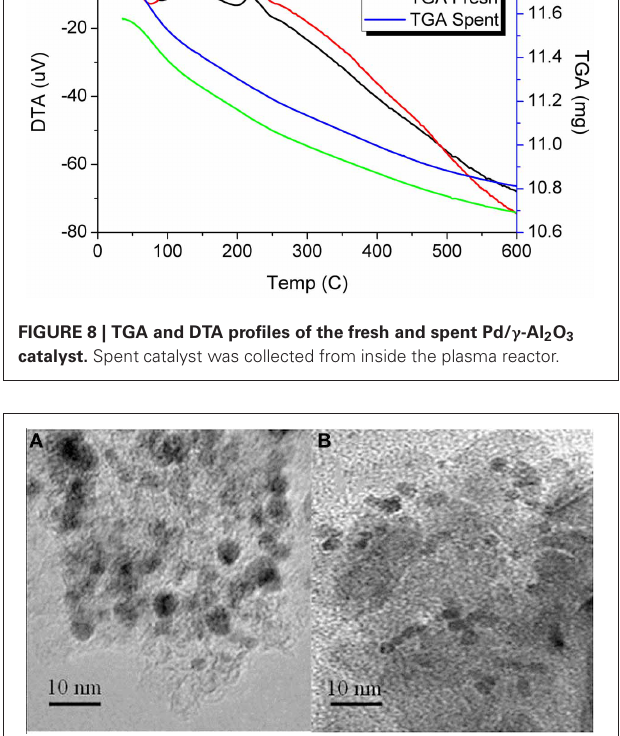
FIGURE 9 | TEM pictures of the Pd/ γ -Al 2 O 3 catalyst: before (A), and after (B) the plasma/catalytic test. Spent catalyst was collected from inside the plasma reactor.